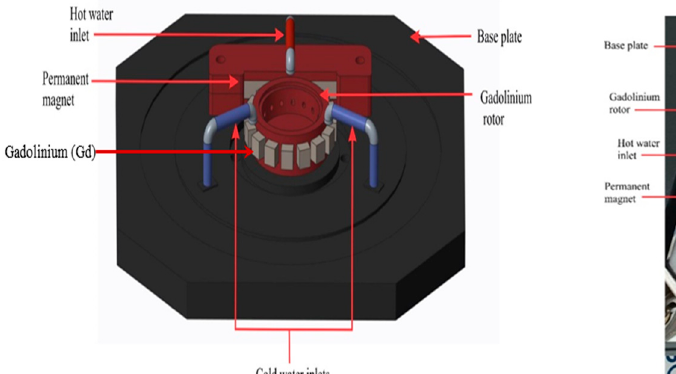
Figure 3. Change in RPM and torque with varying hot water temperature.